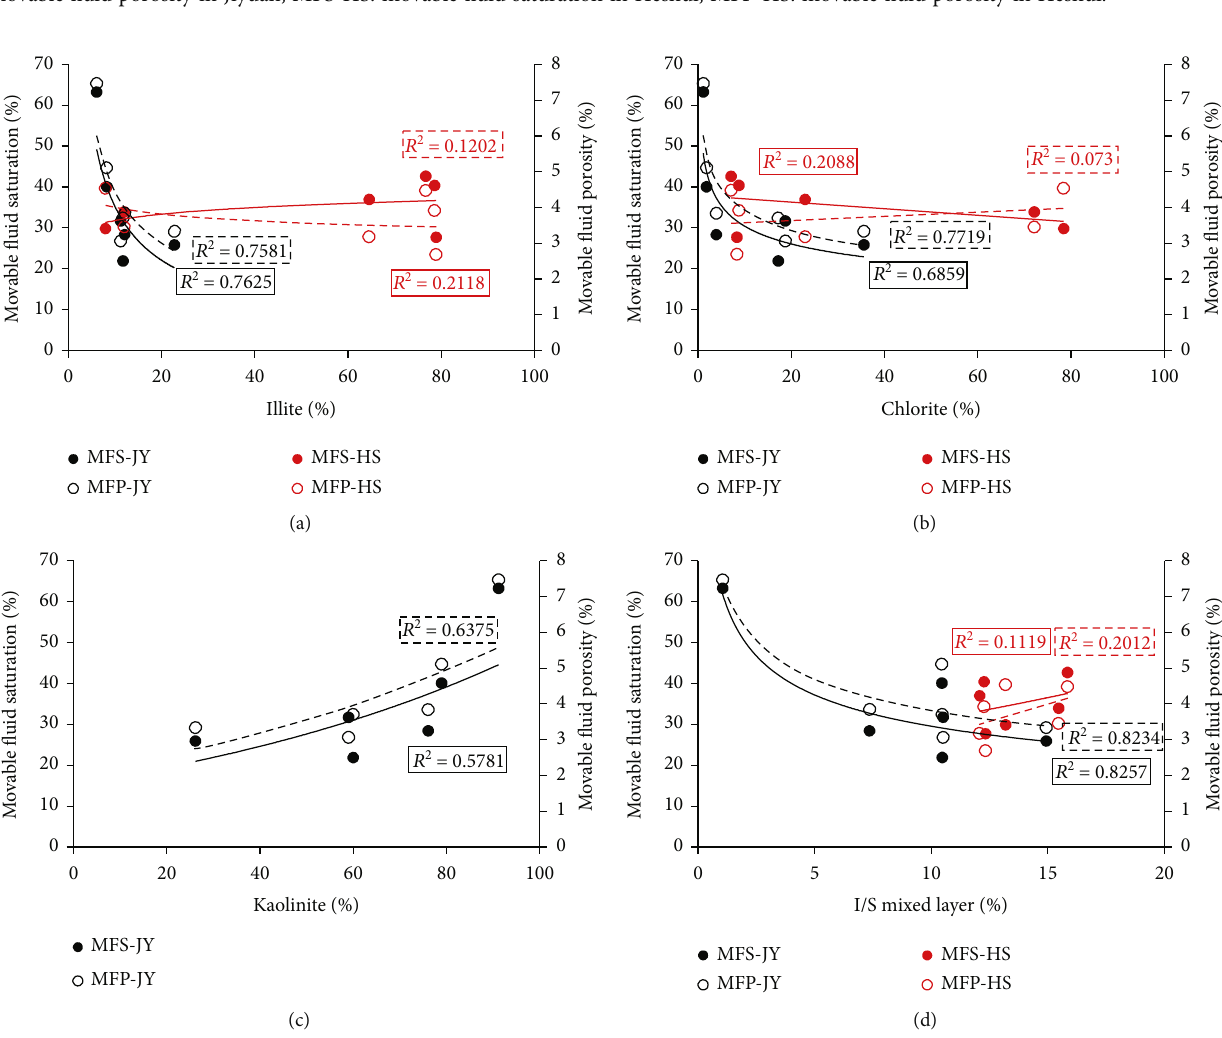
Figure 9: Relationship between physical properties and movable fl uid parameters. MFS-JY: movable fl uid saturation in Jiyuan; MFP-JY: movable fl uid porosity in Jiyuan; MFS-HS: movable fl uid saturation in Heshui; MFP-HS: movable fl uid porosity in Heshui.